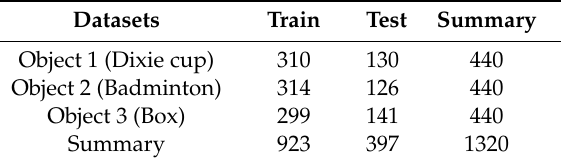
Table 2. RGB Datasets.